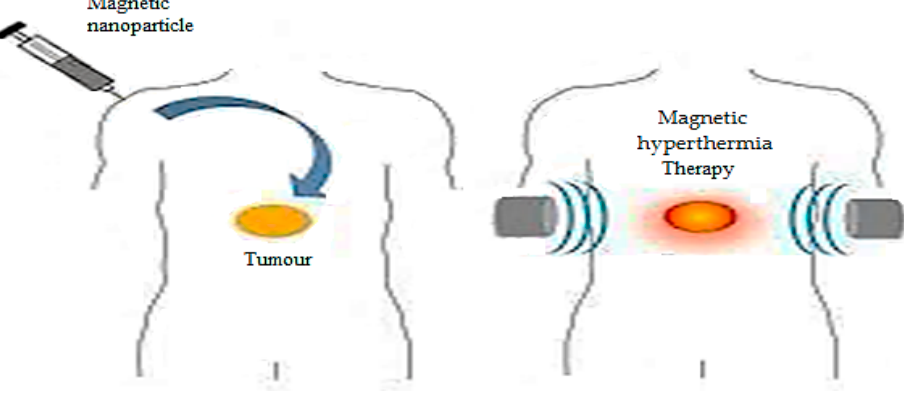
Figure 8. Artificially induced hyperthermia (taken from [77]).